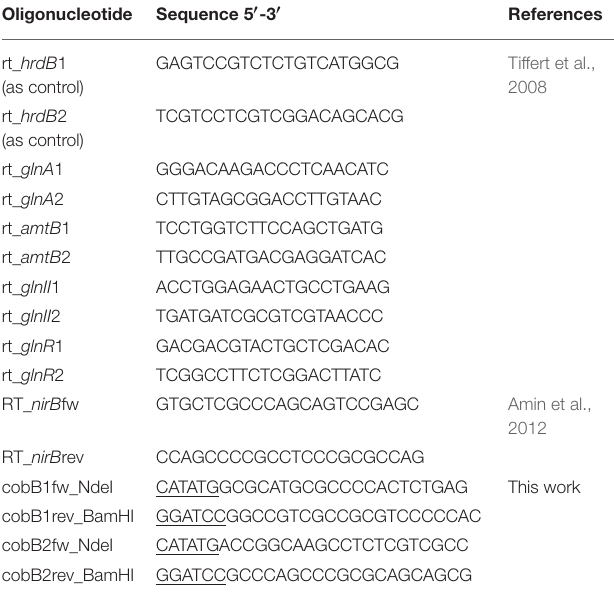
TABLE 2 | Primers used in this